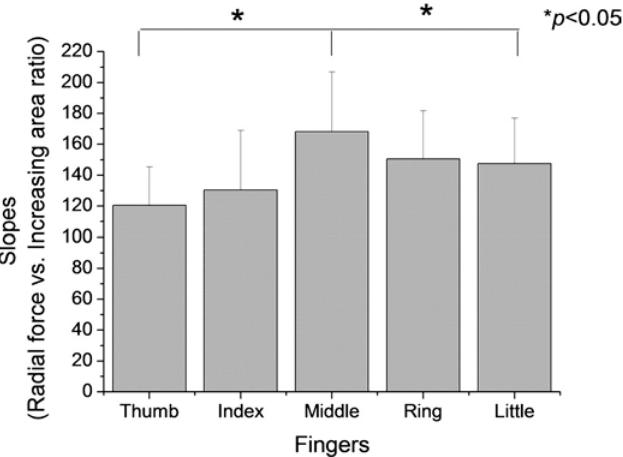
Figure 1 The slope of the linear region of the force vs. increasing area ratio curve was defined the stiffness of the